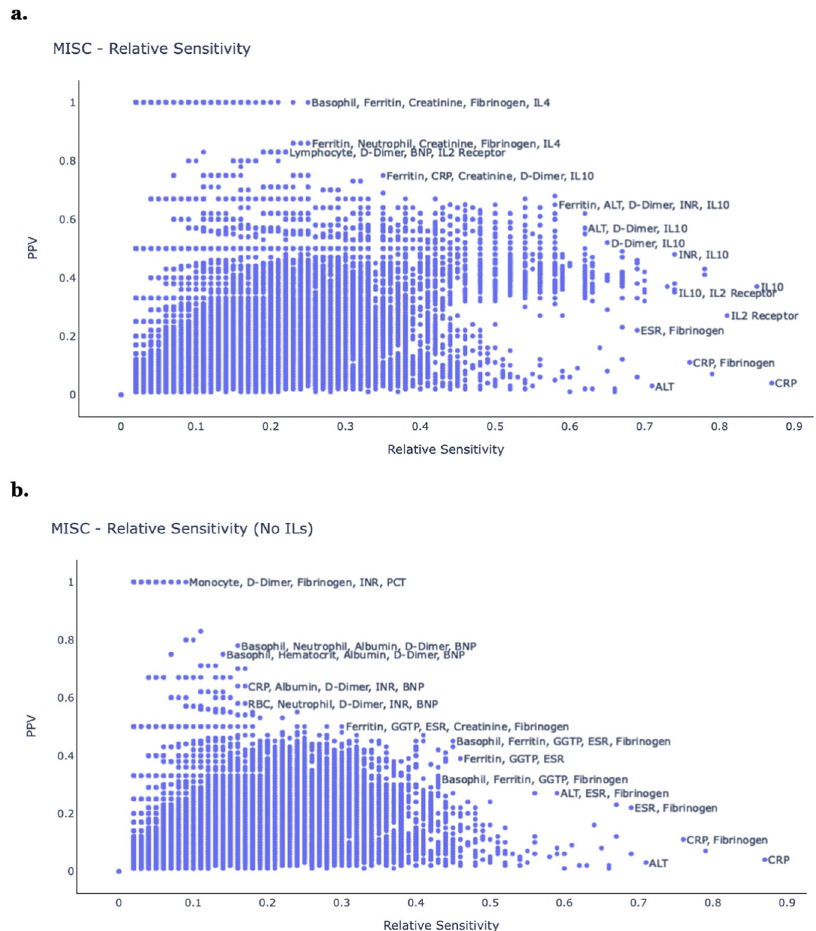
Fig. 6 Individual approach, MIS-C. Comparison of different laboratory test combinations, according to the relative sensitivity for MIS-C (X- axis), and the PPV (Y-axis). Results are shown a with IL tests and b without IL